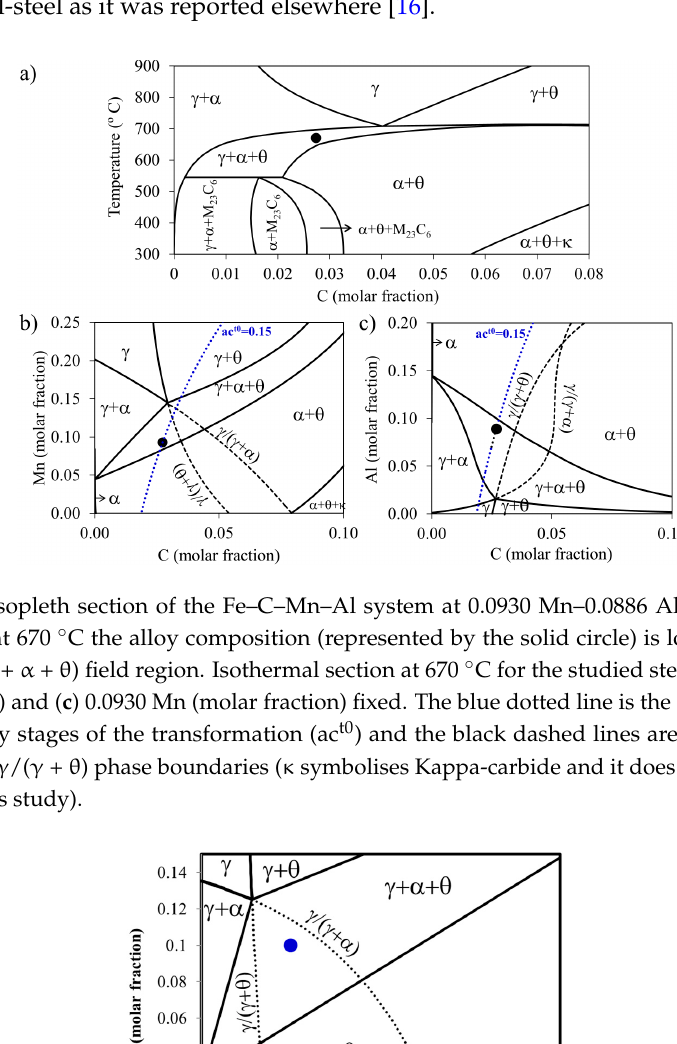
Figure 2. Isothermal section at 600 °C for the studied Mn-steel at 0.0966 Mn fixed. The black dashed lines are the extrapolated γ /( γ + α ) and γ /( γ + θ ) phase boundaries.